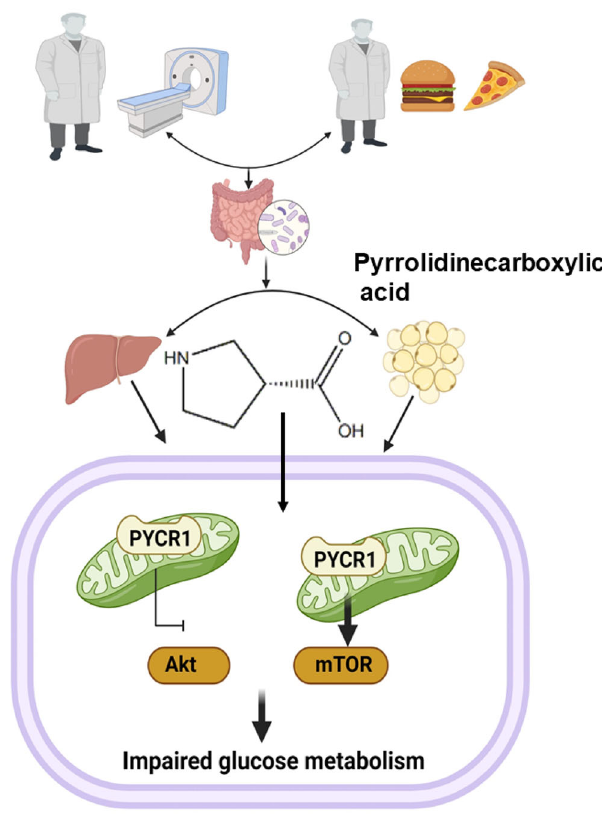
Fig. 9 Flowchat of potential mechanism of this study. Figure was created by Ruixue Huang and the elements used was permitted by Biorender (https://biorender.com/) because Ruixue Huang is one of the registered